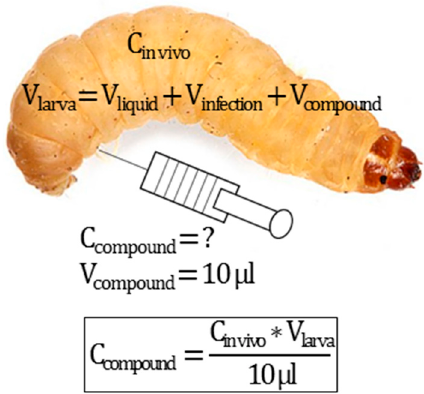
Figure 5. Example of the calculation of the concentration of the injected compound solution. In cases where a specific in vivo concentration is required (C in vivo ), the concentration of the injected compound solution (C compound ) can be calculated, for a specific volume of injection (V compound , typically 10 µL) and for any larva volume (V larva ). The V larva is the sum of the larva liquid volume (V liquid ), as calculated from the curve presented in Figure 1 and the injection volumes (typically two injections, one for the infection V infection and one for the treatment, 10 µL each).